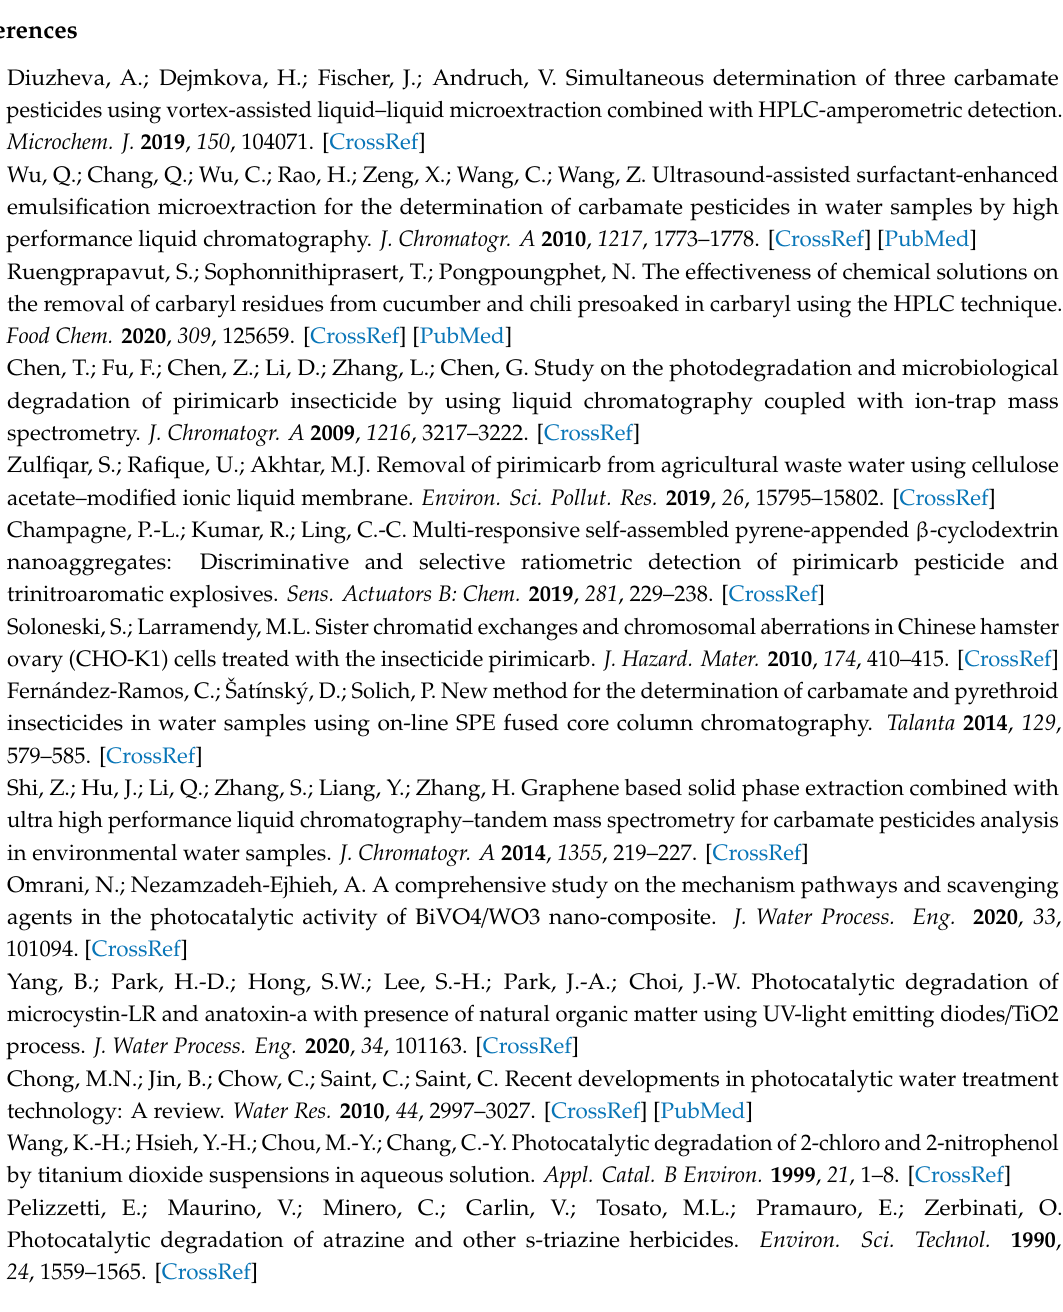
Figure S1: Variation in the relative distribution of the intermediate products obtained from the photocatalytic degradation of pirimicarb as a function of irradiation